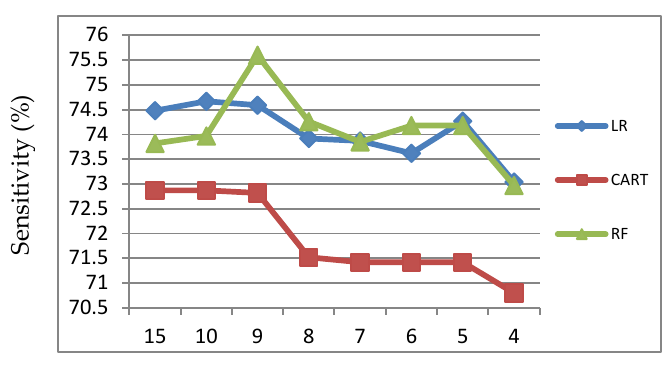
Figure 1. Accuracy of LR, CART and RF with input of significant variables identified by LR.